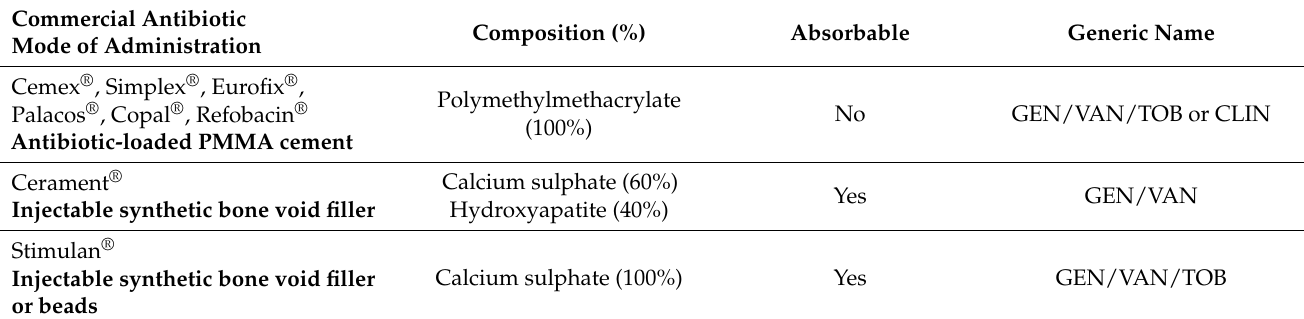
Table 1. Local delivery antibiotics in diabetic foot